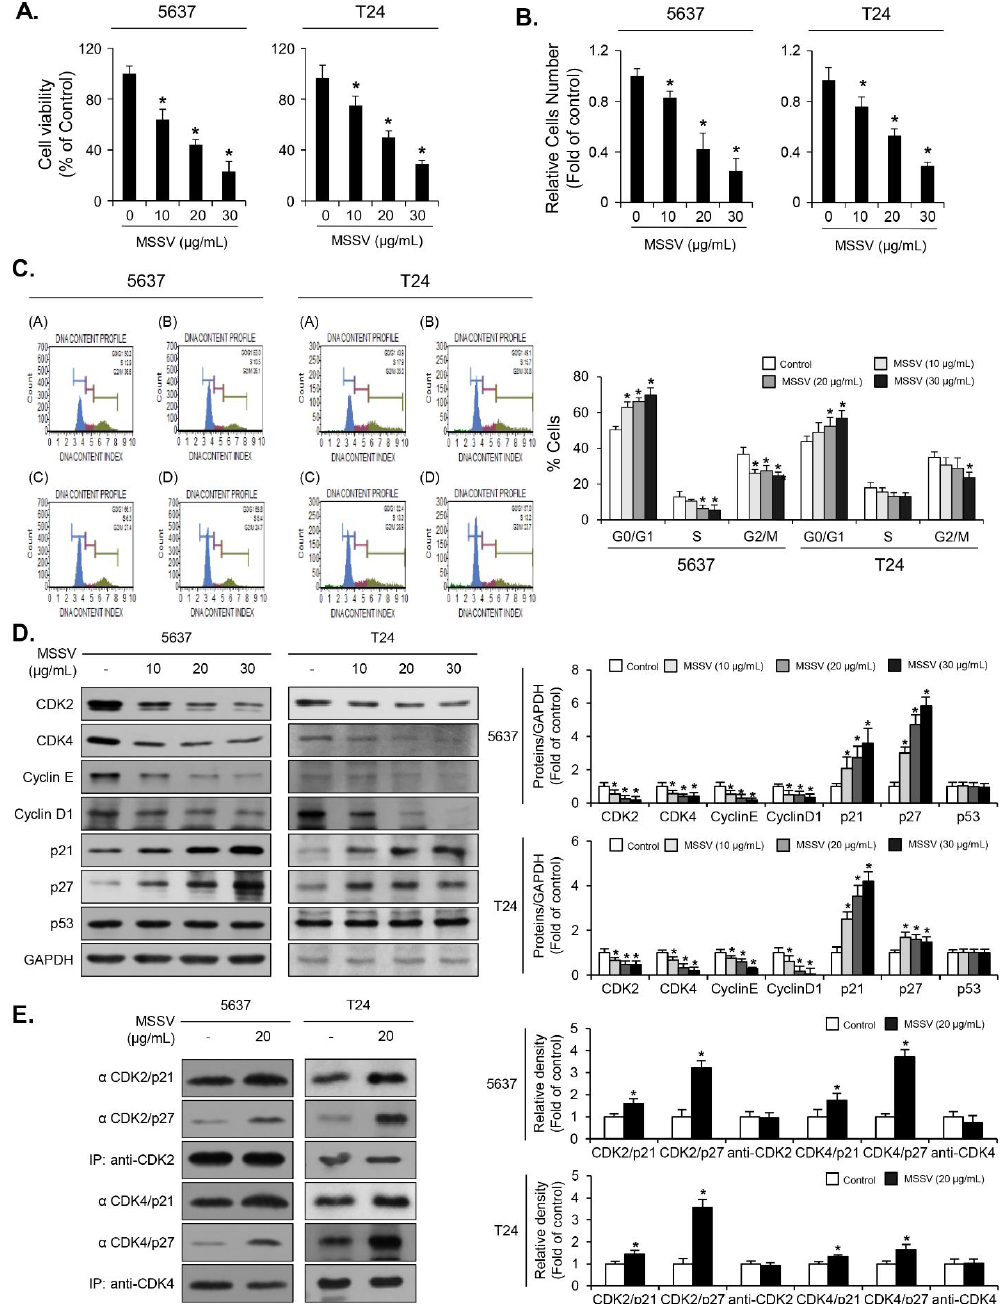
Figure 2. MSSV-mediated inhibition of proliferation of the human bladder cancer cell lines, 5637 and T24, was owing to G1-phase cell cycle arrest. ( A ) Both cell lines were treated with or without MSSV at the indicated concentrations for 24 h, followed by MTT assays for cell viability. ( B ) Cells were treated with indicated concentrations of MSSV for 24 h, and cell counting was performed via trypan blue staining. ( C ) Both cell lines were treated with MSSV for 24 h and analyzed for cell cycle distribution using fluorescence-activated cell sorting (FACS) histograms. The percentage of cells in each cell cycle phase is presented. ( D ) Cells were exposed to MSSV at the indicated concentrations for 24 h. The expression levels of cyclin D1, cyclin E, CDK2, CDK4, p21WAF1, p27KIP1, p53, and GAPDH were analyzed via immunoblotting. Bar graphs show the relative fold changes in proteins at different MSSV concentrations in comparison with the control. ( E ) The cell lysates were immunoprecipitated with antibodies recognizing CDK2 and CDK4, followed by immunoblotting with specific antibodies against p21WAF1, p27KIP1, CDK2, and CDK4. Graphs show the relative amount of immunoprecipitated proteins as fold changes in comparison with the control. For the bar graphs, values were presented as the mean ± SD of three independent experiments; * p < 0.05, compared with the control group. Uncropped Western Blot Images in Figures S3 and